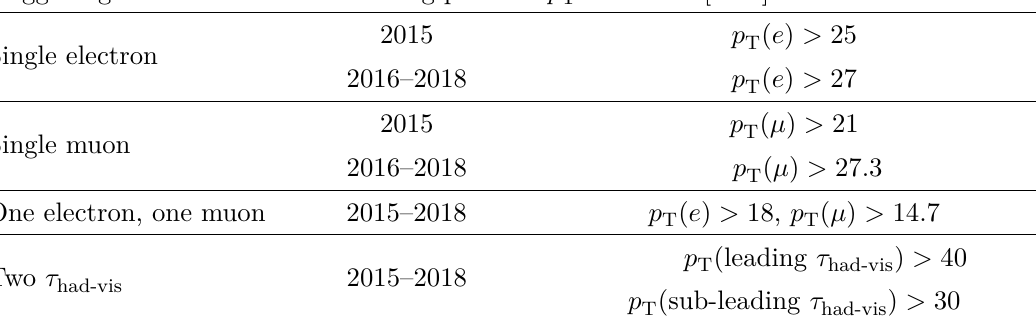
Table 2. Transverse momentum thresholds applied to the selected electrons, muons and τ depending on the trigger signature and the data-taking period. The p lowest unprescaled triggers during the Run 2 data-taking are reported in refs. [128–131]. The electron and muon trigger menu evolution throughout the Run 2 data-taking is discussed in refs. [43, 44].